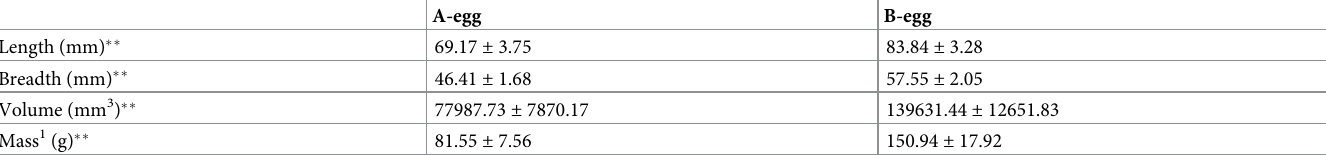
Table 2. Comparison of A-eggs (n = 22) and B-eggs (n = 51) of erect-crested